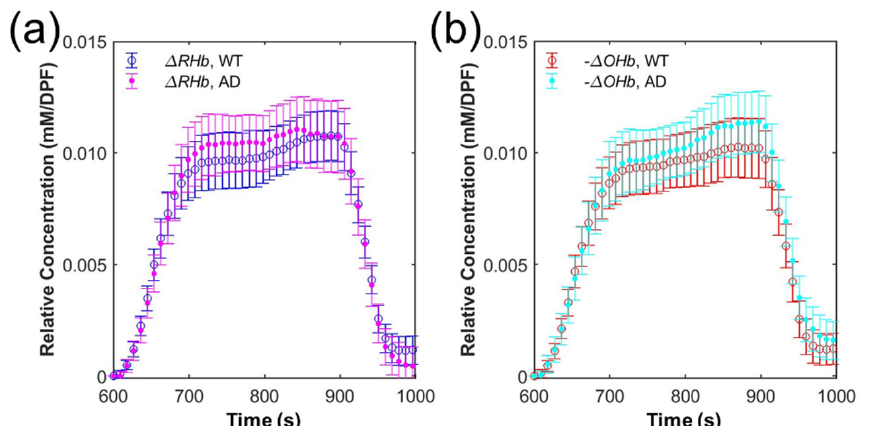
Figure 5. ( a ) Grand average and 95% confidence interval of relative deoxyhemoglobin concentration change ( ∆𝑅𝐻𝑏 ) of wild-type (WT) (blue circle) and Alzheimer’s disease (AD) (purple dot) mice. ( b ) Grand average and 95% confidence interval of the negative relative oxyhemoglobin concentration change ( −∆𝑂𝐻𝑏 ) of WT (red circle) and AD (cyan dot).